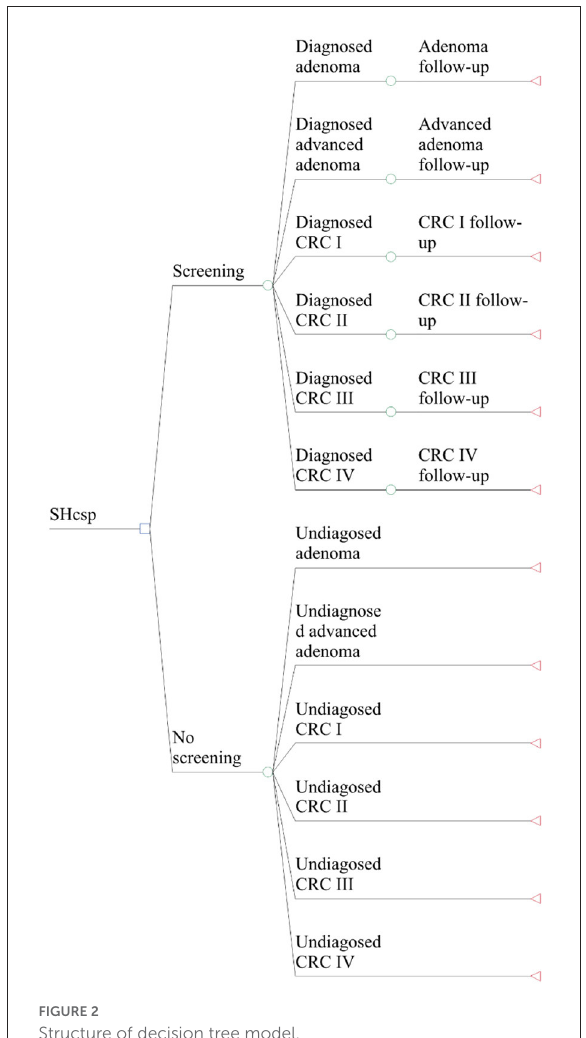
FIGURE2 Structure of decision tree